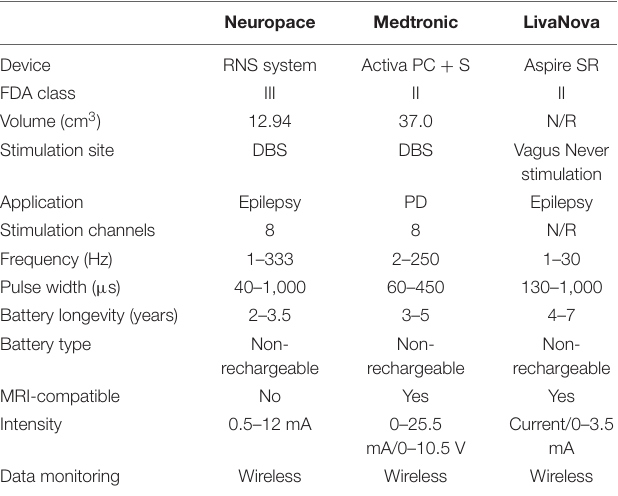
TABLE 2 | Closed-loop neural stimulation